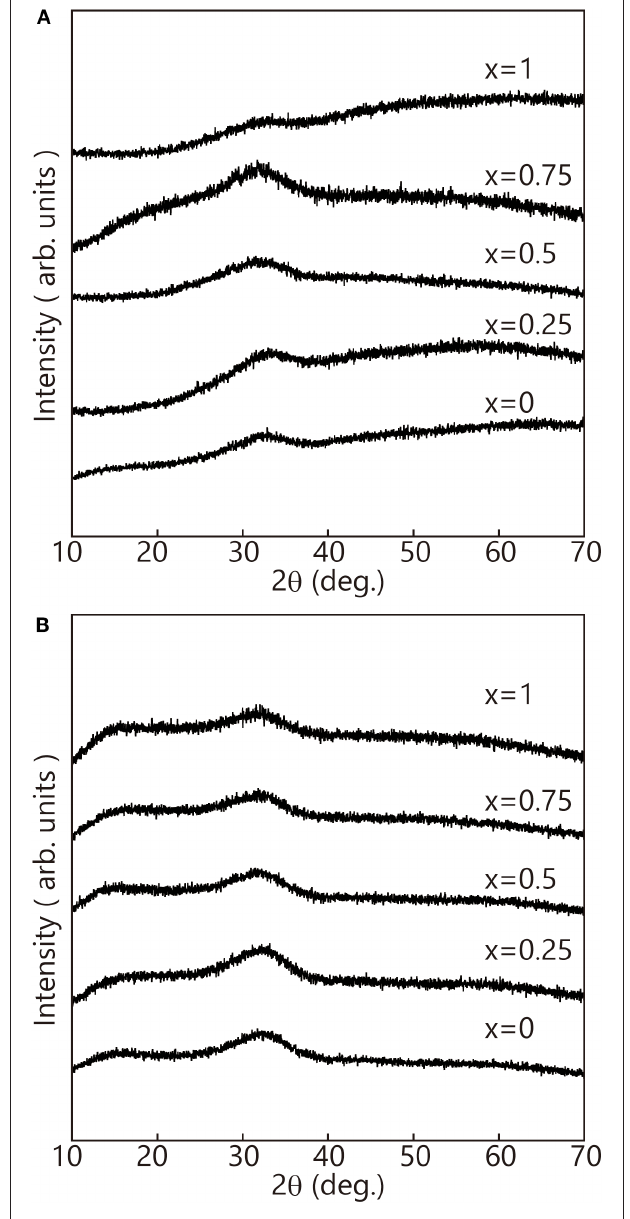
FIGURE 3 | Density of the fabricated Na 2 Fe x Ni 1 − x P 2 O 7 glass and Na 2 M P 2 O 7 ( M = Ni, Fe)